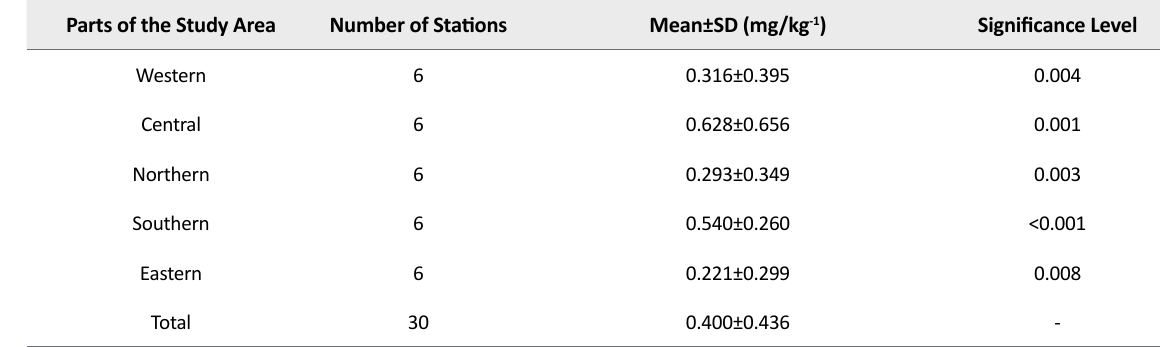
Table 1. The residual diazinon concentrations (mg/kg -1 ) in the rice samples in each zone of the studied area